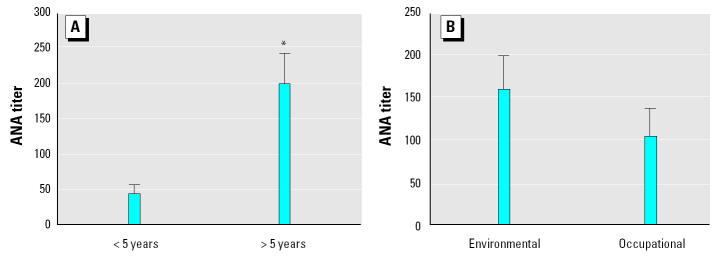
ANA titer (mean ± SD) for subsets of the Libby samples based on length of asbestos exposure (A) or source of exposure (B) as environmental (household contact, used in garden, etc.) or occupational (worked in vermiculite mine or processing).
*p < 0.01 by two-tailed t-test.